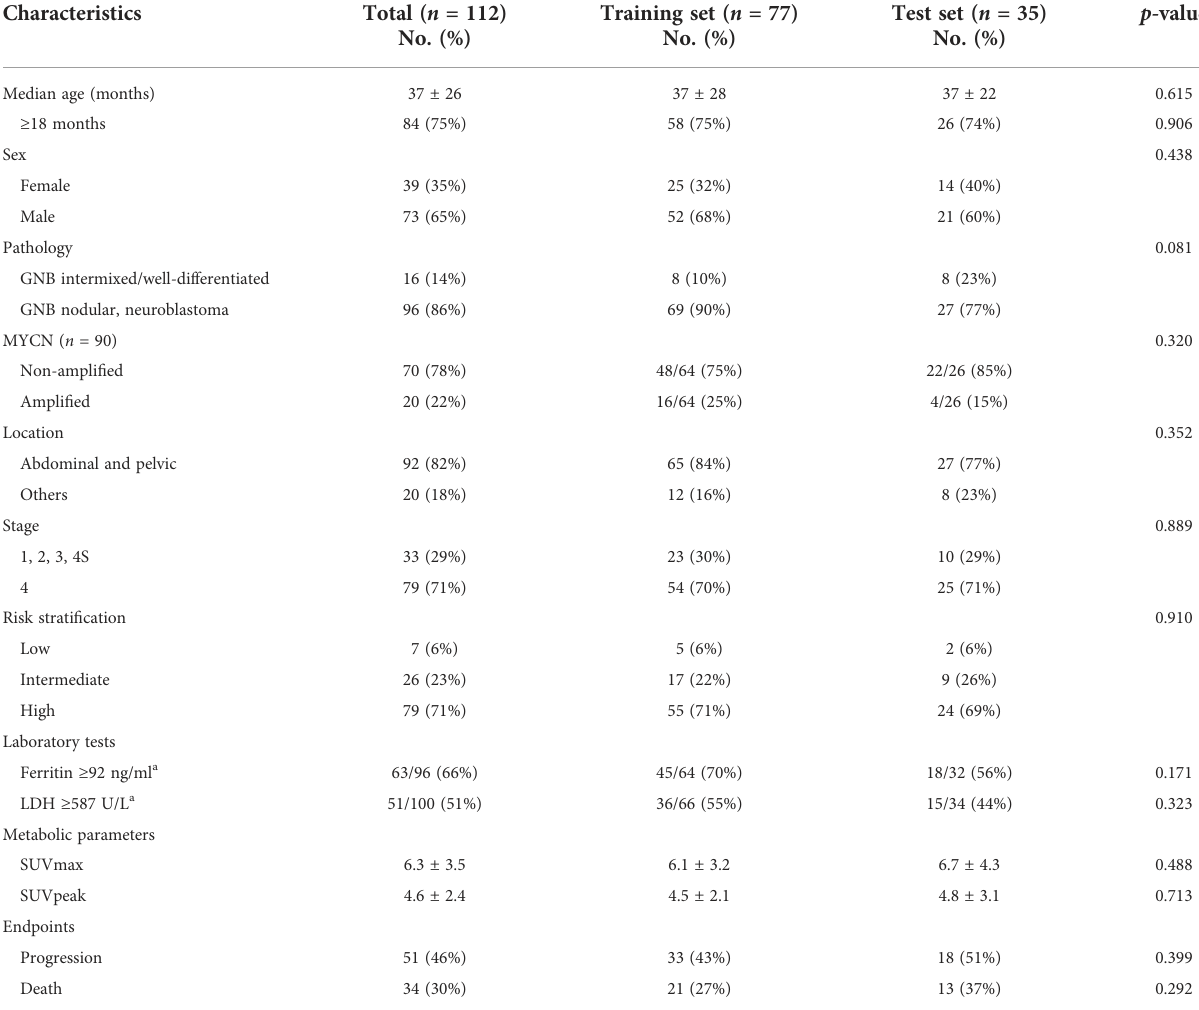
TABLE 1 Patient